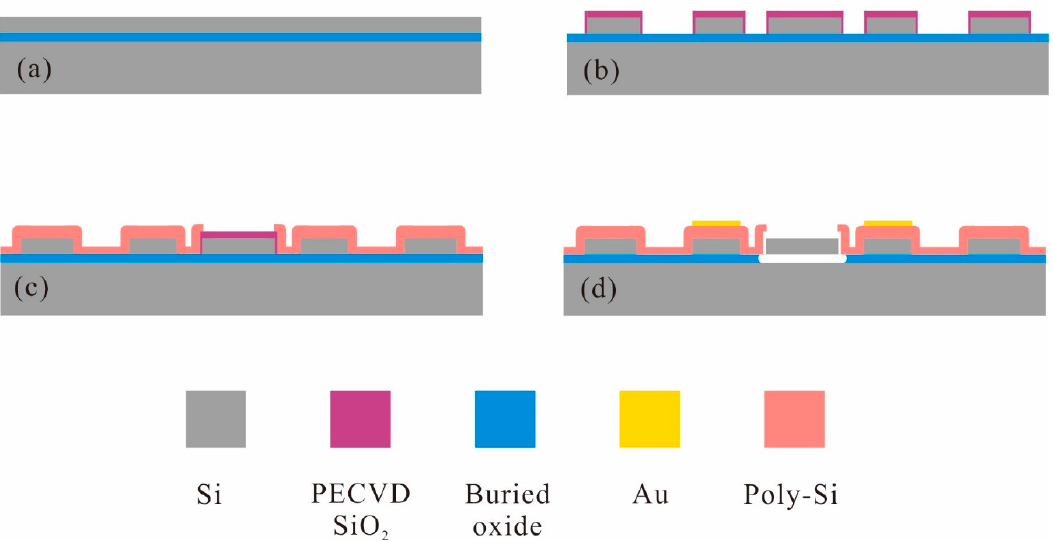
Figure 4. Fabrication process for the Lamé-mode resonator.